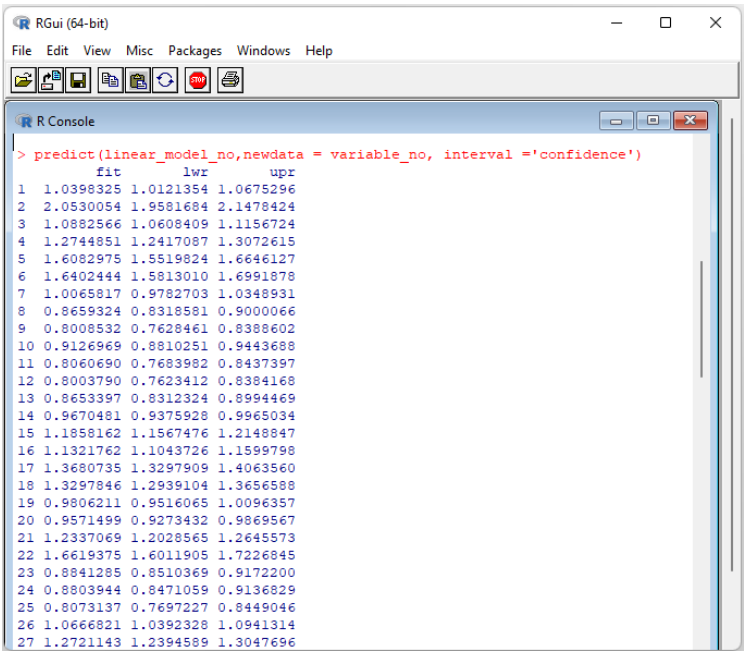
Figure 6. Example of results from executing the predict function for CO data vectors based on cor- relation with NO (within the execution of the created R program).